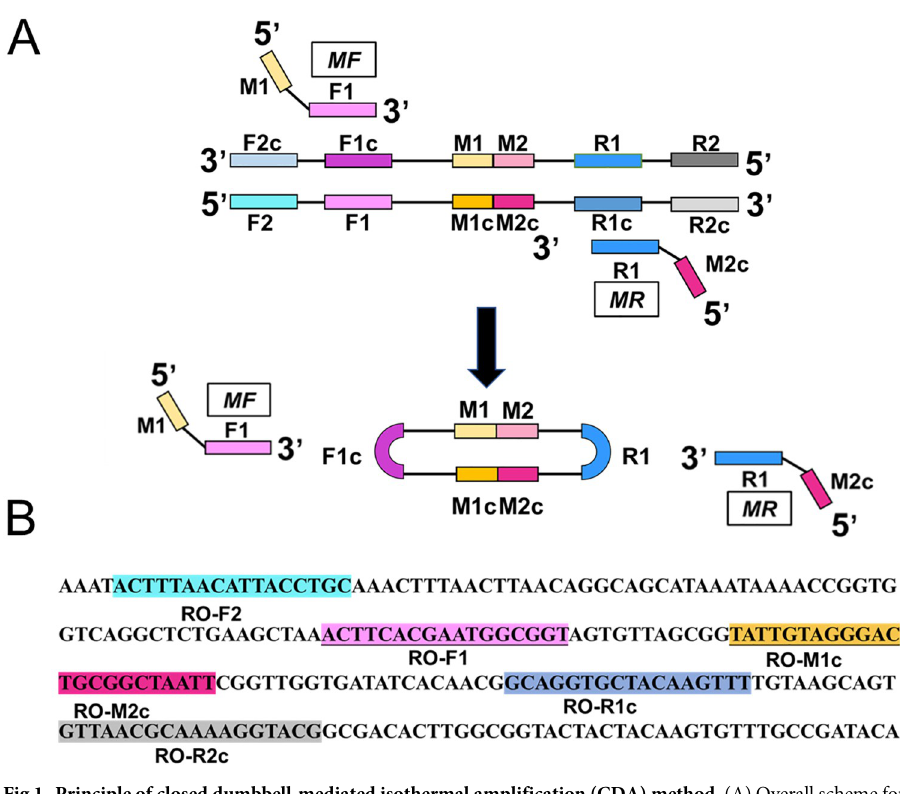
Fig 1. Principle of closed dumbbell-mediated isothermal amplification (CDA) method. (A) Overall scheme for primers used in CDA method. (B) Partial sequence of the ompA gene of R . raoultii used for designing the primers of CDA method.